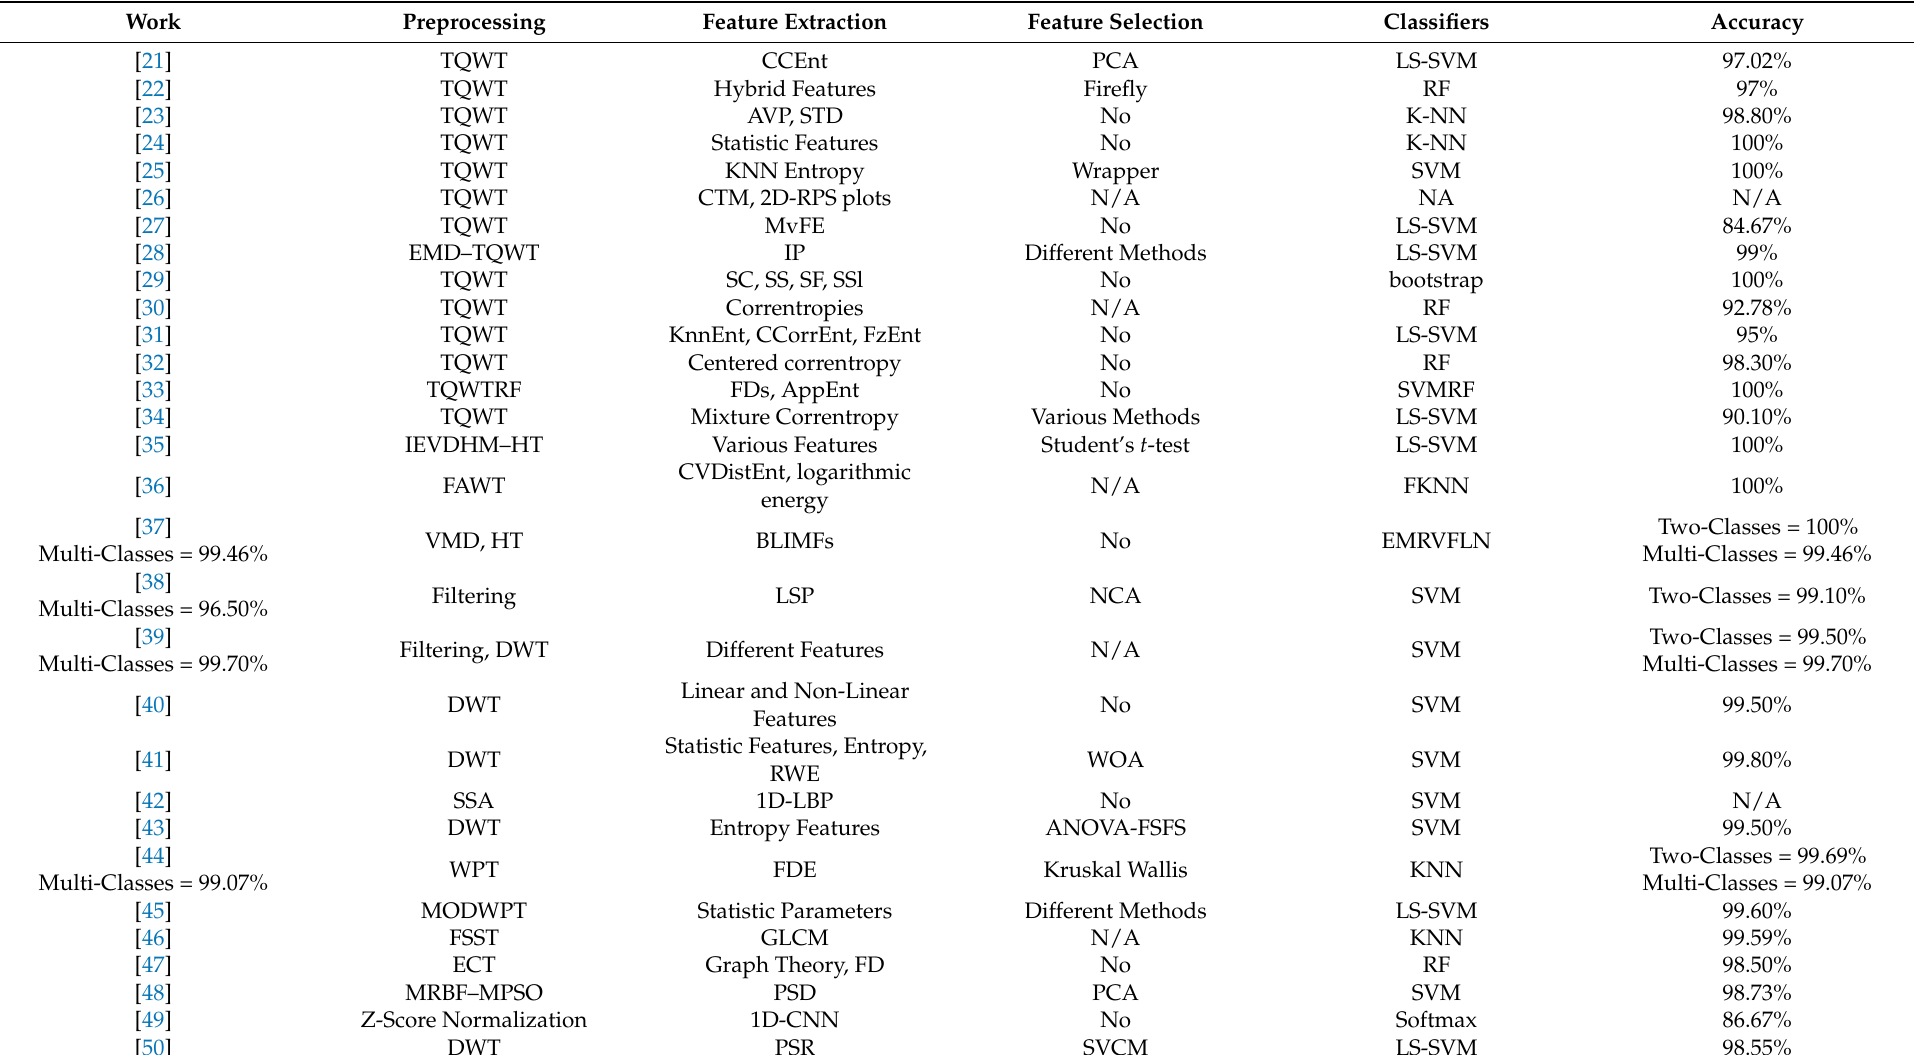
Table 8. Comparison of the proposed method with other related works for the Bonn